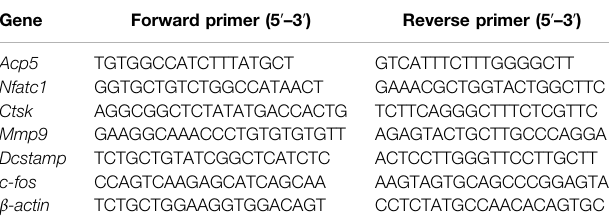
TABLE 1 | The primer sequences of the osteoclast-related genes used in